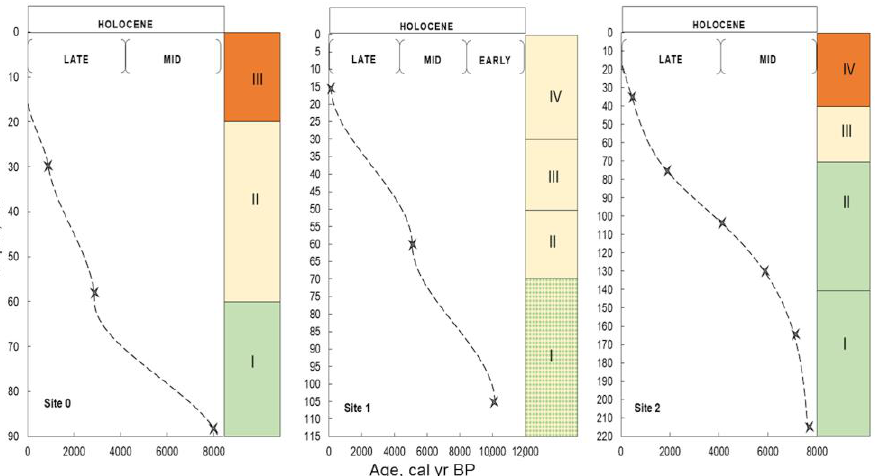
Figure 9. Peat accumulation rate reconstructed from radiocarbon dates within different stages of the Holocene (KOM). The color scale shows the stages of bogs’ genesis: ombrotrophic (orange), transi- tional (yellow), minerotrophic (green). I-IV correspond to the paleo-communities from Figures 3 – 5. Stars represent peat sampling depths.